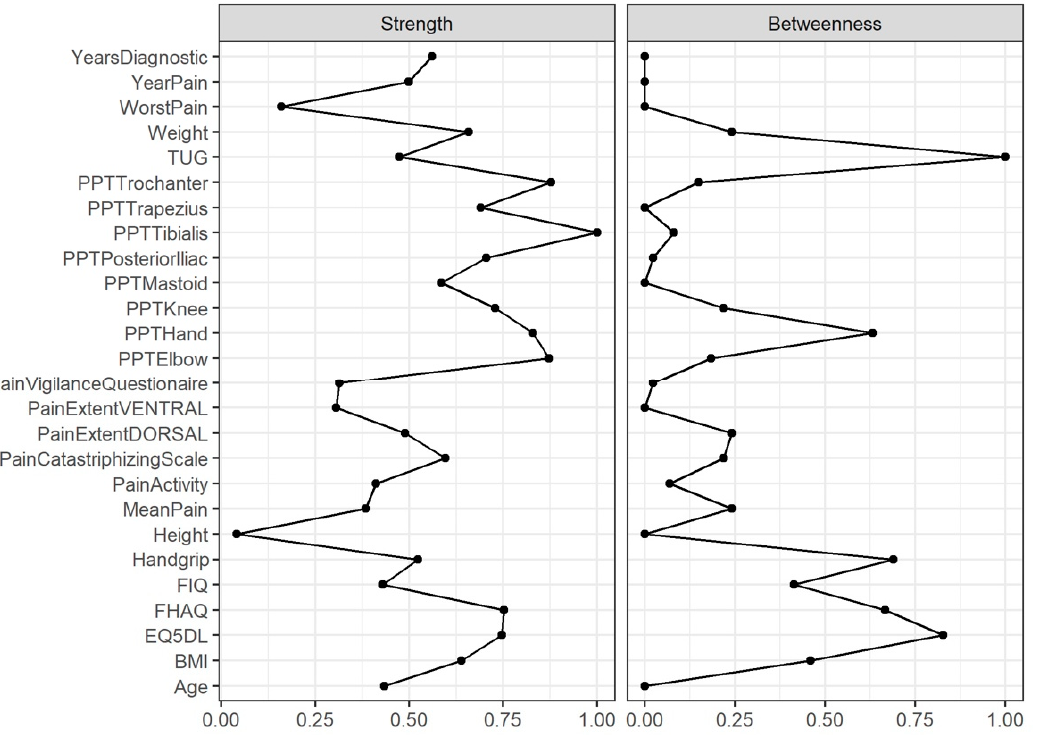
Figure 4. Centrality measures of strength and betweenness of each node in the network. A centrality value of 1 indicates maximal importance, and 0 indicates no importance.